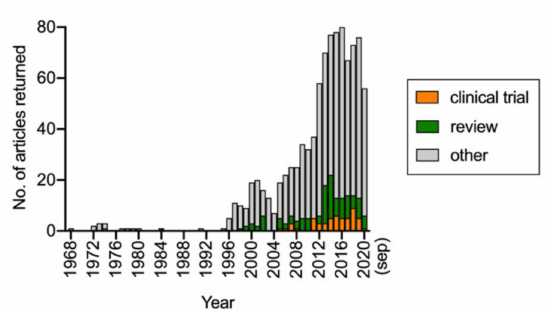
Figure 2. Results of a PubMed search conducted on 17 September 2020 with the search word “palmitoylethanolamide” and range 1968–present. Subsections with “clinical trial” and “review” indicated as article type were also downloaded from PubMed.